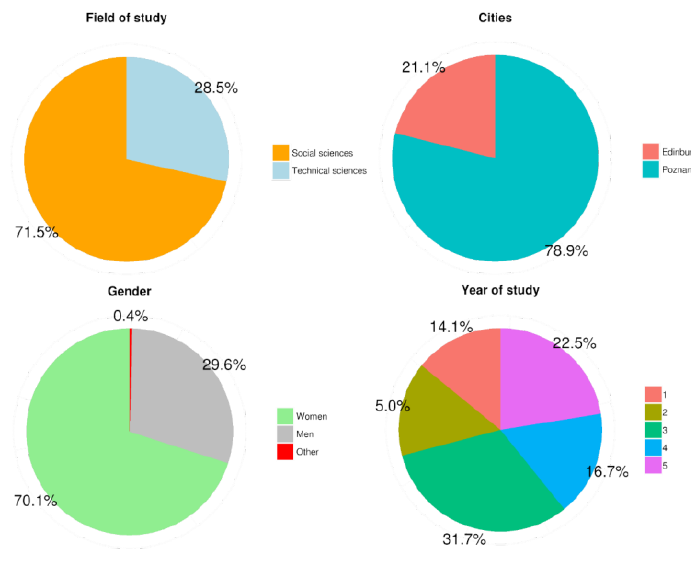
Figure 2. Respondents’ characteristics.